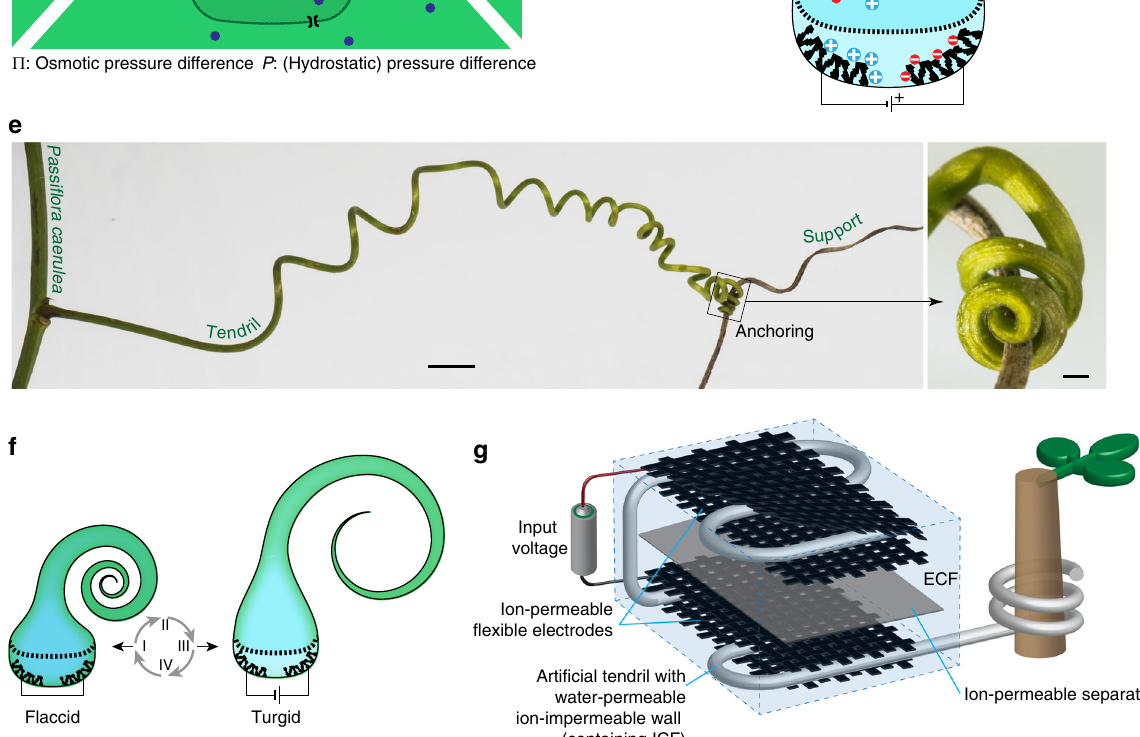
Fig. 1 Osmosis-based reversible actuation: from plant cell to a tendril-like soft robot. a , b Stomata guard cells in a fl accid and b turgid state: schematic and optical images of Tradescantia zebrina leaves (courtesy of Andrea Degl ’ Innocenti). Scale bars: 10 µ m. c , d Cyclic osmoregulation (schematic) c for plant cell and d for our osmotic actuator. The concentration of ions (osmolyte) was controlled in the electroactive control unit through the reversible immobilization on the surface of electrodes, as driven by an input voltage (ions are released to the fl uid bulk upon short-circuiting). Ion concentration modulation drives the water fl ux as in plant cells, and modulates the soft effector stiffness. e Passi fl ora caerulea tendril reaching and anchoring to an external support. Scale bars: 5 mm main image, 0.5 mm detail. f Arti fi cial tendril actuation (schematic). g Tendril-like soft robot based on the osmotic actuator